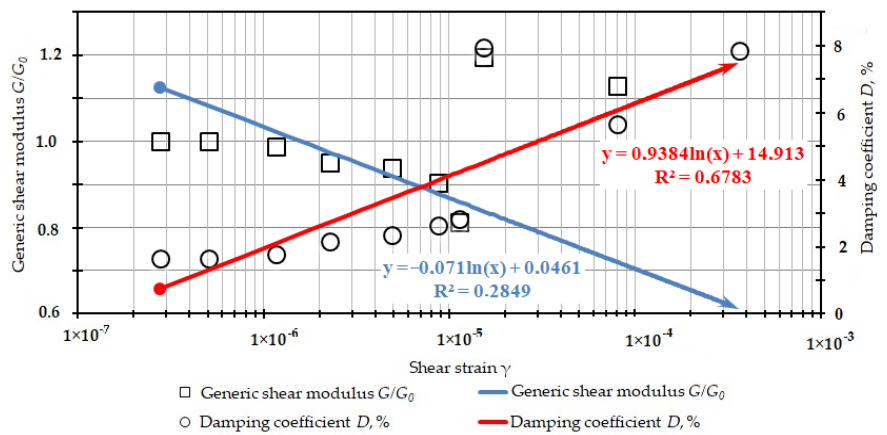
Figure A1. Graph of dependencies of generic shear modulus G/G 0 (unit fractions) and damping coefficient D (%) on the amplitude of shear strains γ (unit fractions) for cement stabilized soils. Test 1 (resonant column).